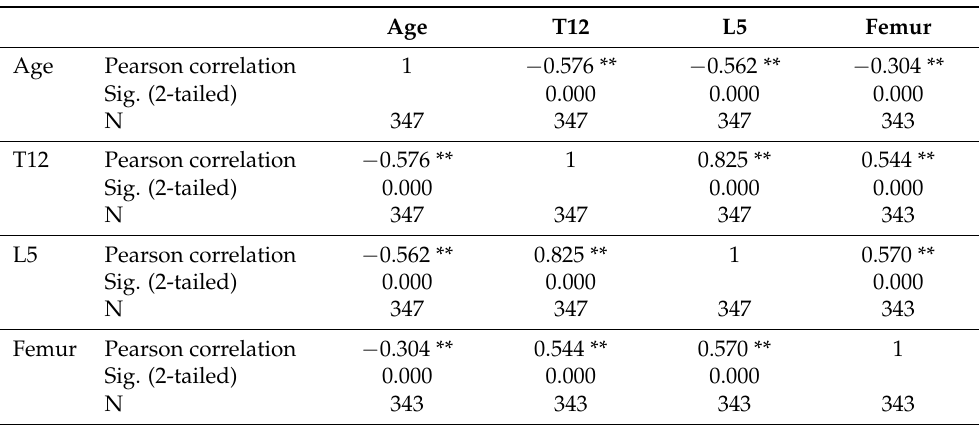
Table 3. The correlations between Age, T12, L5 and